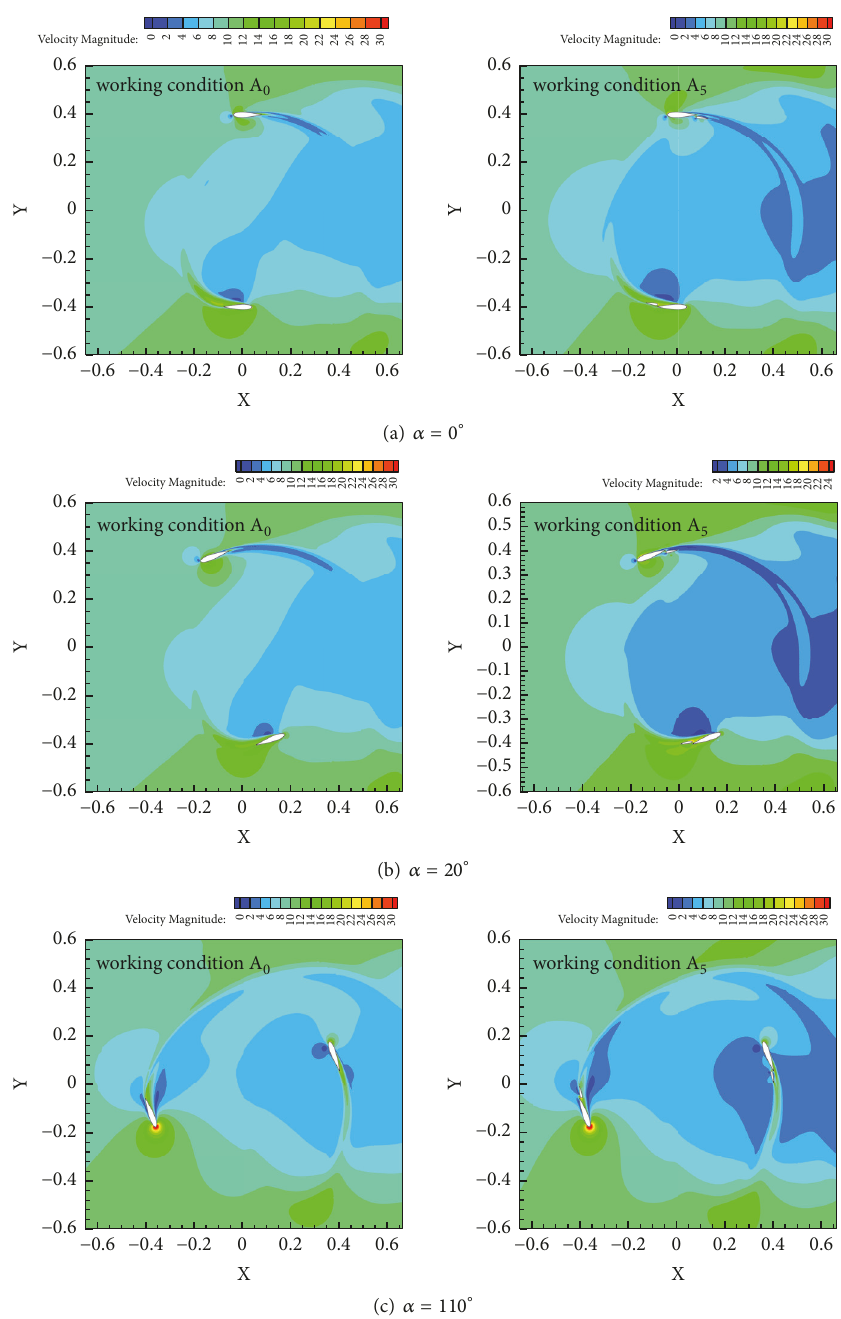
Figure 9: Velocity contours of working condition